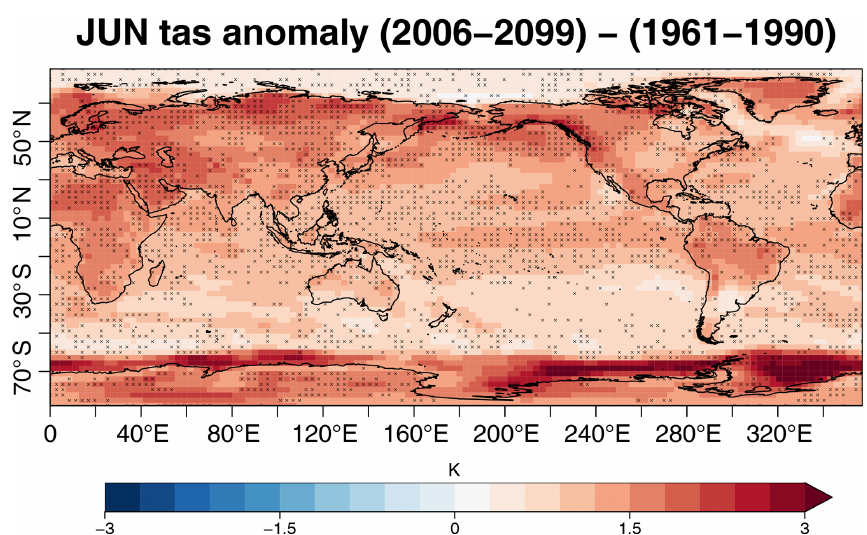
Figure 1. Multi-model mean of projected future June near-surface air temperature anomalies (2006–2099) compared with the period of 1961–1990 (colors). Crosses indicate that the 80% of models agree with the sign of the multi-model mean anomaly. The models used in this example are BCC-CSM1-1, MPI-ESM-MR and MIROC5 (r1i1p1 ensembles) for the RCP2.6 scenario. All models have been regridded to the BCC-CSM1-1 grid using a linear interpolation scheme. See Sect. 3.1 for details on recipe_multimodel_products.yml .